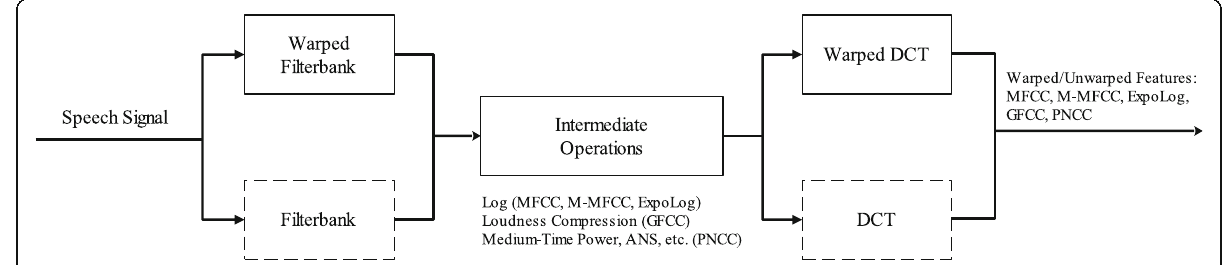
Fig. 2 The process of frequency warping in the filterbank and/or DCT domain(s) to obtain the corresponding warped features of MFCC, M-MFCC, ExpoLog, GFCC, and PNCC in one or both of the warping domains. The dashed boxes represent the no-frequency warping cases. Intermediate operations performed for each feature extraction method are also